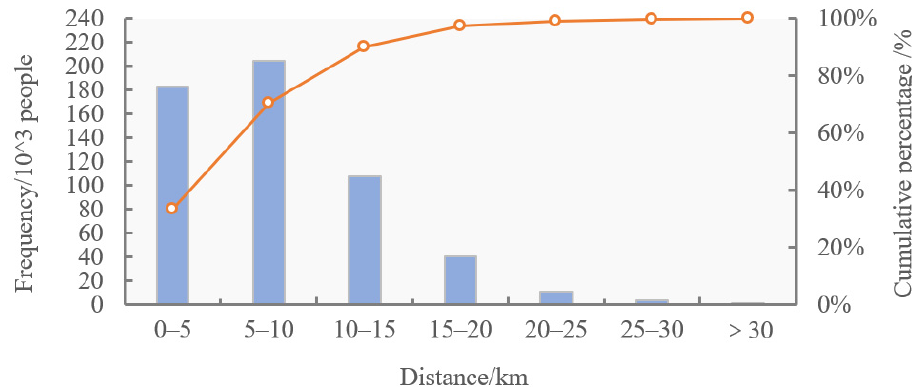
Figure 4. Distribution of metro travel distance for the elderly.